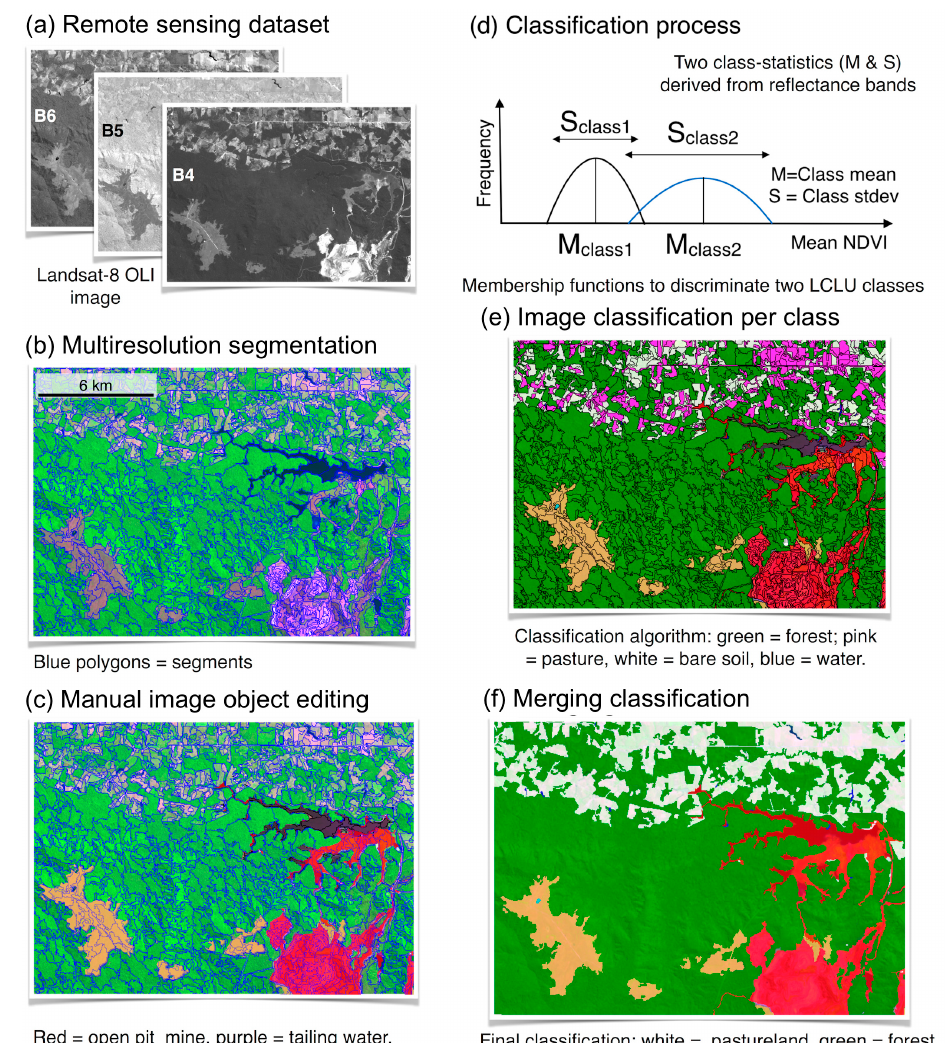
Figure 3. Empirical GEOBIA workflow that illustrates the principles of the segmentation procedure: ( a ) remote sensing data set analysis, ( b ) multiresolution segmentation, ( c ) manual image object editing, ( d ) classification process based on segmentation, ( e ) image classification per class, and ( f ) merging and quantifying the classifications, which incorporates GIS concepts.